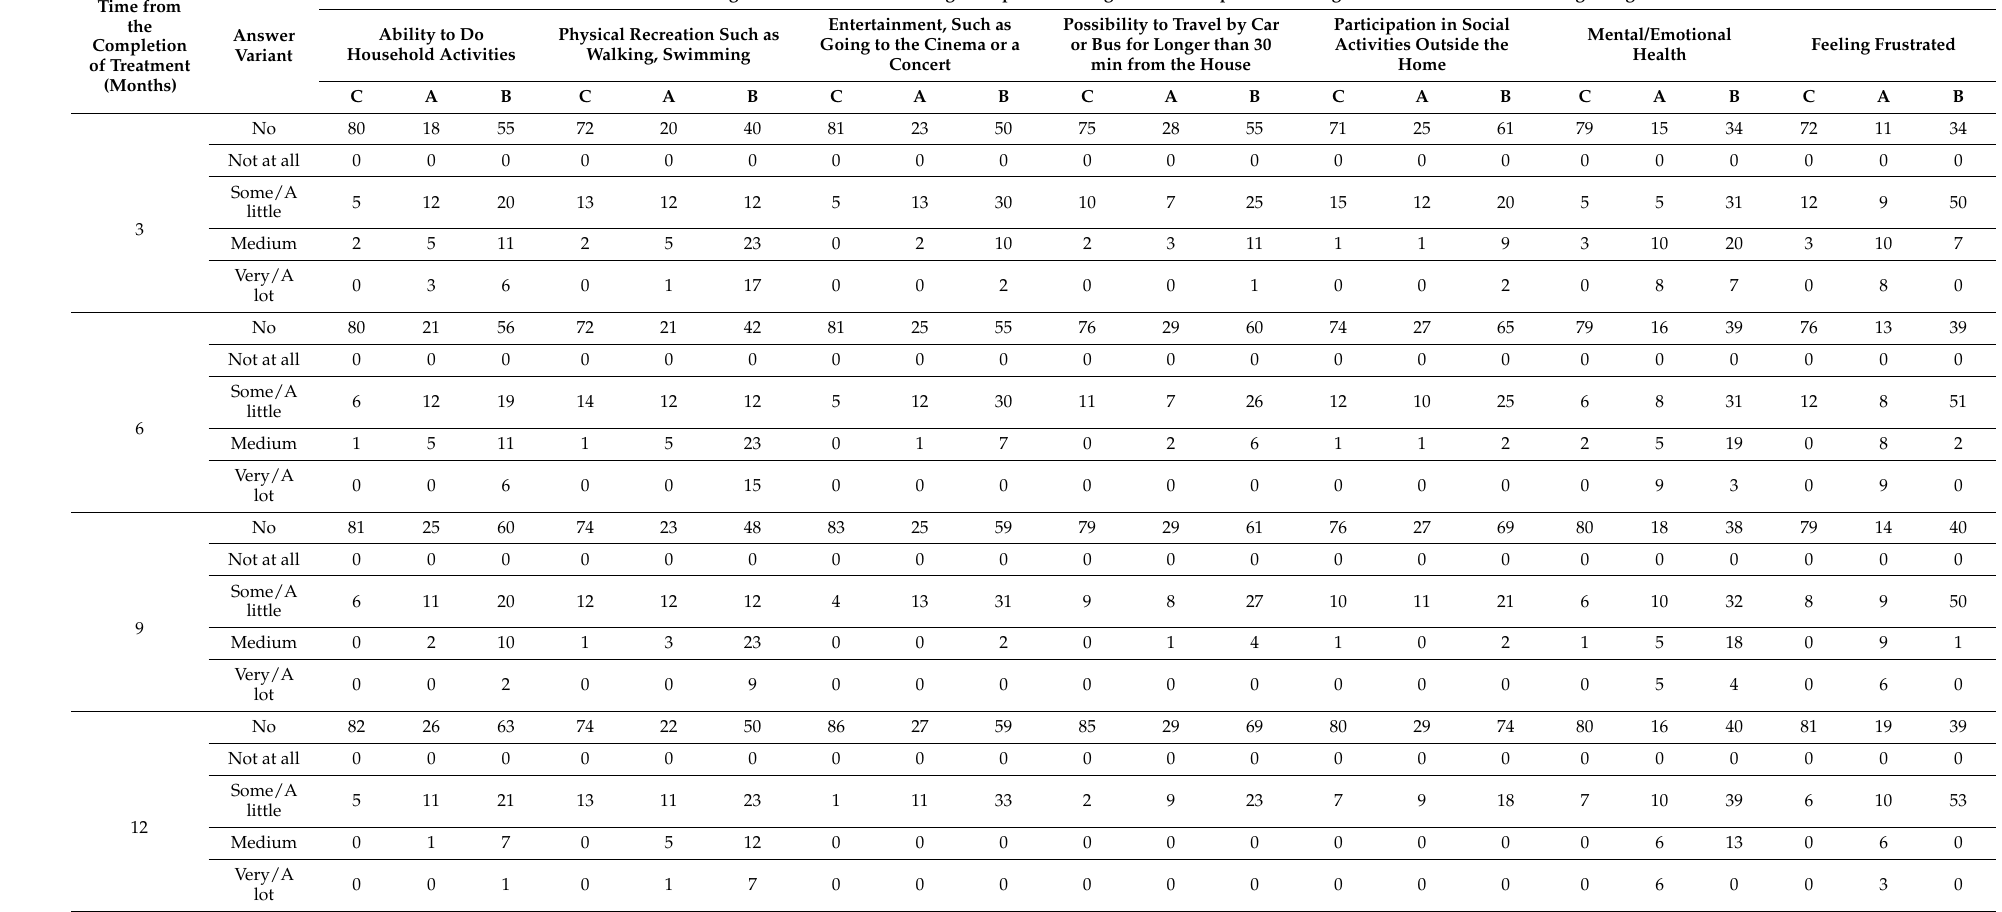
Table 4. Results of II-Q7